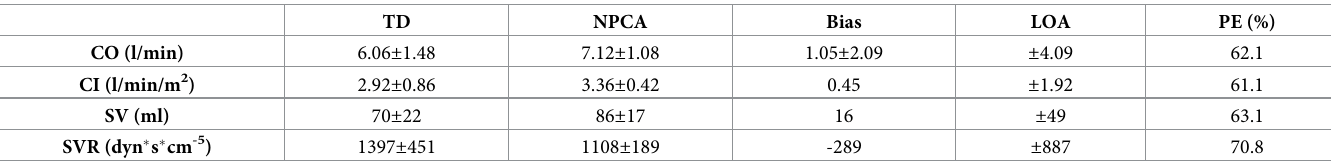
Table 2. Hemodynamic assessment HTX patients–Thermodilution versus NPCA.